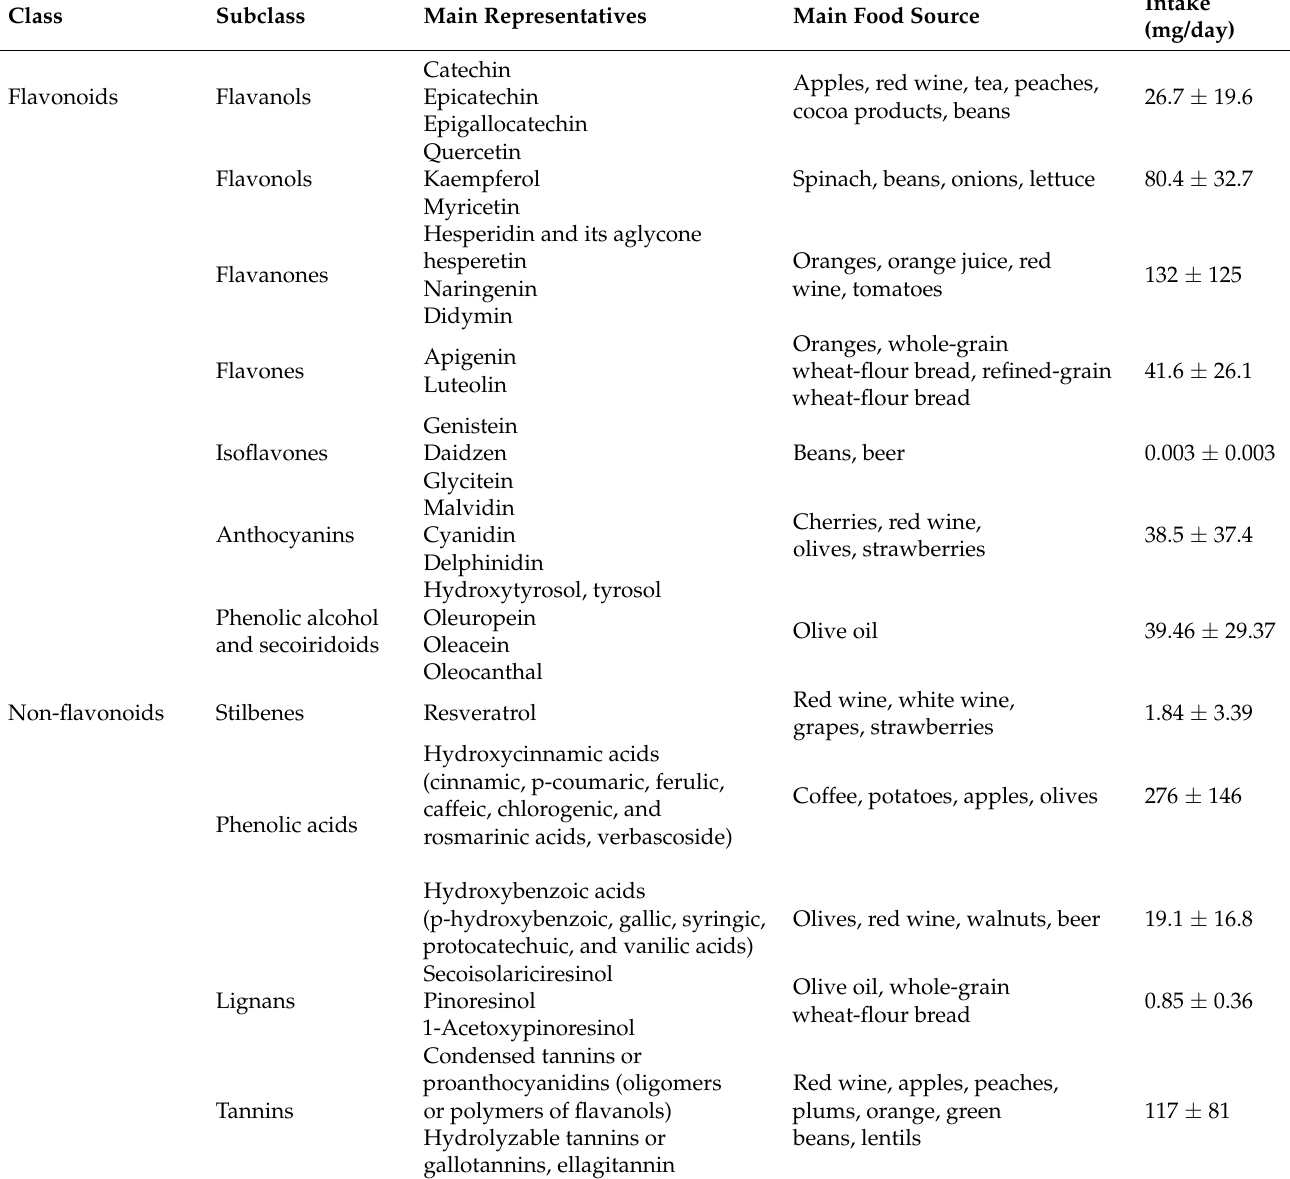
Table 1. Main Mediterranean diet polyphenols, food sources and dietary